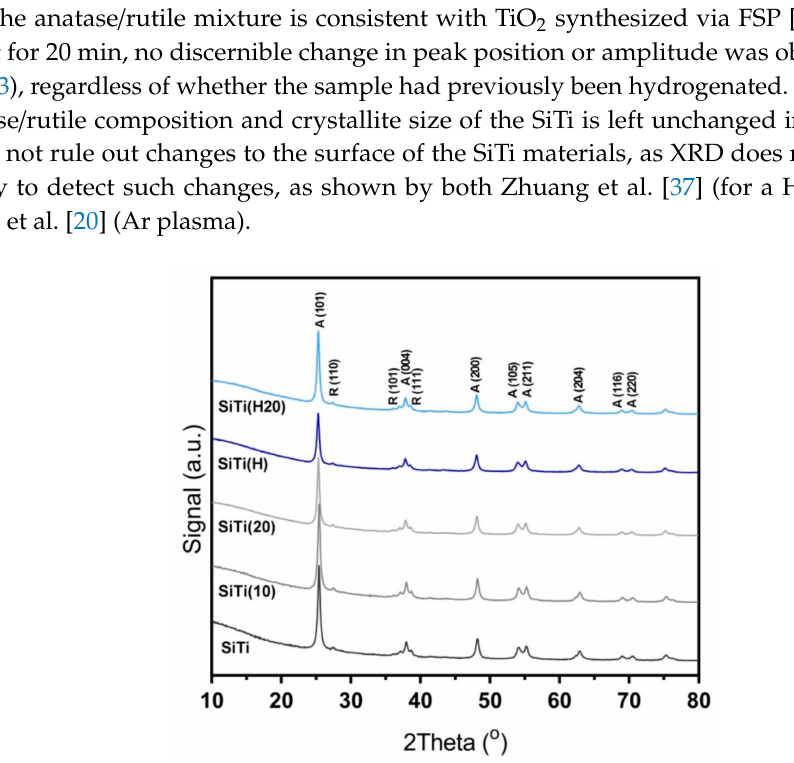
Figure 3. XRD reflections for FSP-synthesized SiTi after hydrogenation and / or plasma treatment. Plasma treatment time denoted in brackets. Anatase (A) and Rutile (R) phases